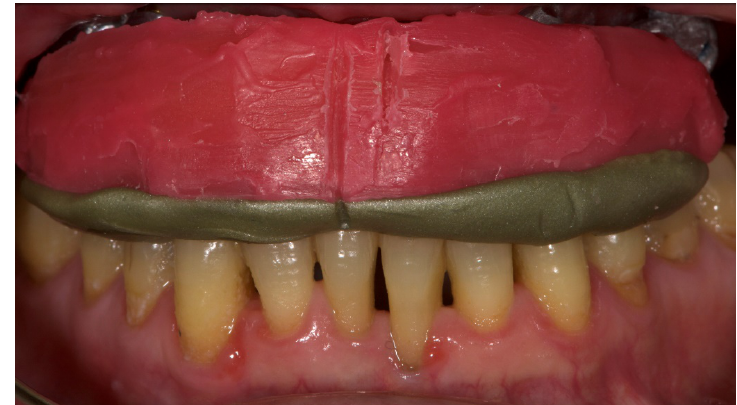
Figure 9. Internal detail of the plaster impression.